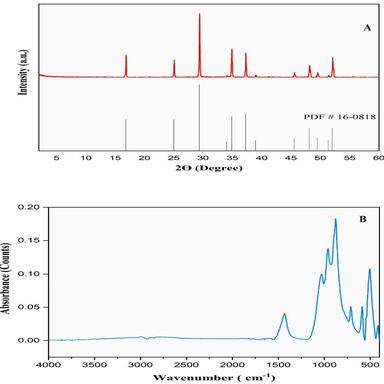
A) XRD pattern of the sodium metasilicate obtained from the reaction of silica fume and sodium carbonate and B) FT-IR of the prepared sodium metasilicate.